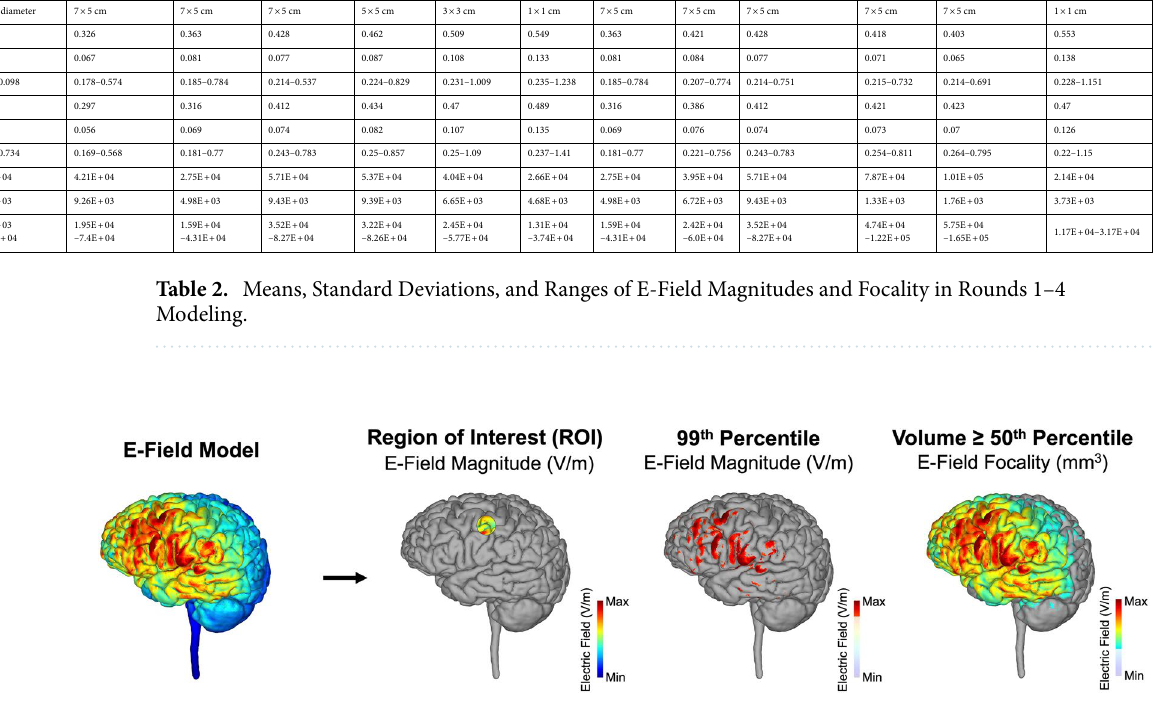
Figure 3. Primary Outcome Measures. For each E-field model, we performed three types of analyses: (1) Region of Interest (ROI) E-Field Magnitude. This method examines the average E-field magnitude in a 10 mm radius spherical ROI that was individually placed at the first gray matter voxel underneath the cortical projection at C3. This ROI was the same for every model and represented the E-field at the on-target cortical motor target. (2) 99th Percentile E-Field Magnitude. This method determined the E-field magnitude at the whole brain level, examining the average E-field in the top 1% of activated voxels irrespective of whether the effects were on-target or off-target. (3) E-Field Focality. We calculated focality by measuring the volume of voxels (mm 3 ) equal to or above the 50th percentile E-field. The greater the volume stimulated, the lower the focality of stimulation (i.e., less focal = higher off-target